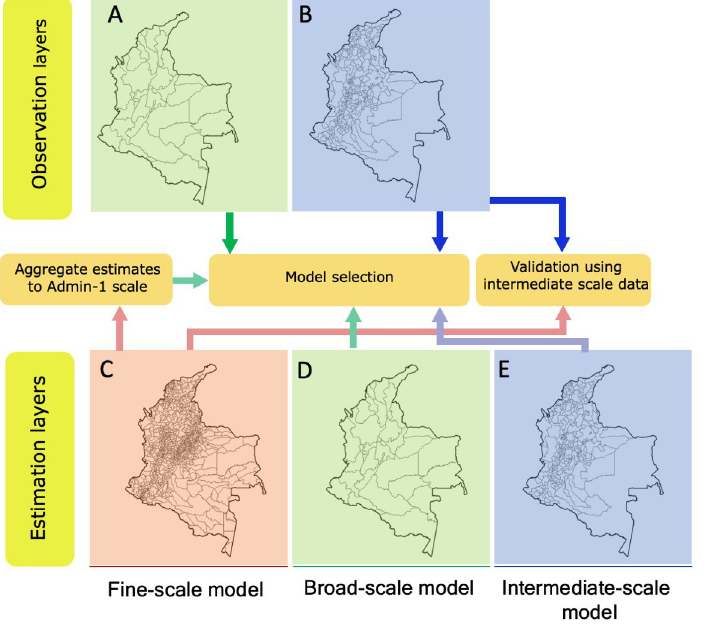
Fig 2. Schematic of the three spatial interaction modeling approaches and subsequent validation. In the first approach (fine-scale), model coefficients are estimated at the municipality level (n = 1122) (C) and used to estimate municipality level migrations, which are subsequently aggregated to the corresponding departments of origin and destination. The estimated department level flows are then used to calculate likelihood (select the best model) based on the observed migrations at the department level (n = 32) (A). In the second approach (broad-scale), model coefficients are estimated at the department level (n = 32) (D) yielding in predicted migration proportions which are used to calculate the likelihood based on observed department level migrations (A). In the third approach (intermediate-scale), model coefficients are estimated at the intermediate level (n = 276) (E), migration proportions are predicted at the intermediate level, and likelihood calculated based on observed intermediate level migrations (n = 276, including 147 single municipality units) (B). To validate our fine-scale model estimates, we used a subset of the intermediate level observation (B) that only includes migrations to and from single-municipality units. Bold lines represent observed data, while deemed lines represent estimates corresponding to each approach namely: fine-scale (red), broad-scale (green) and intermediate (blue).